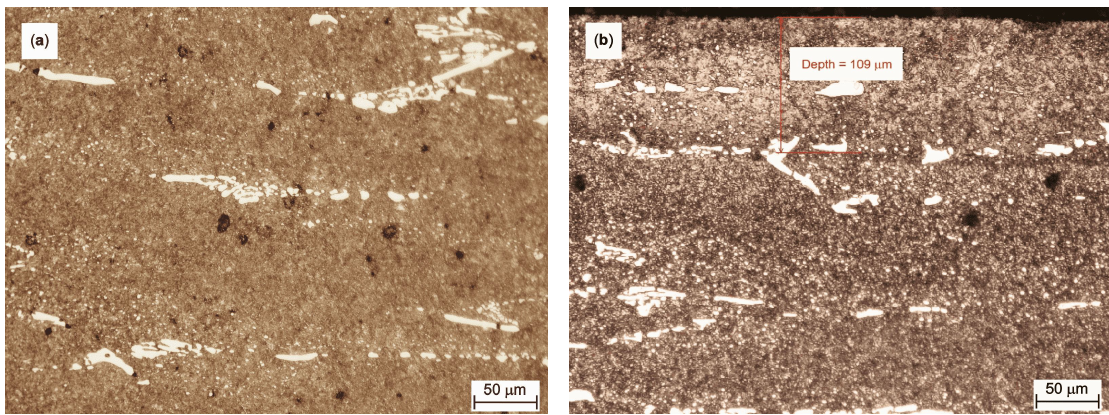
Figure 1. Microstructure of the tested K340 steel samples: ( a ) core-area; and ( b ) nitrided surface layer.